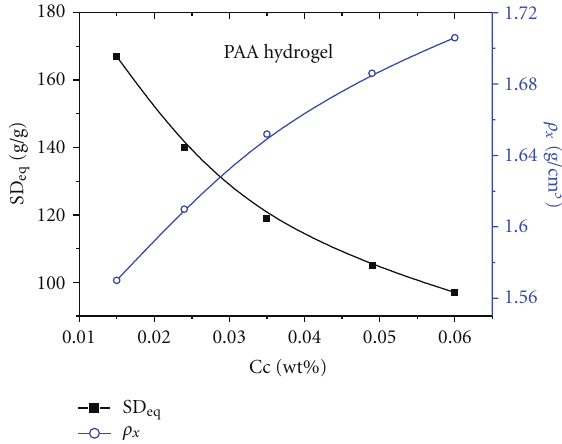
Figure 2: The e ff ect of Cc on macroscopic properties of the synthesized PAA xerogels.